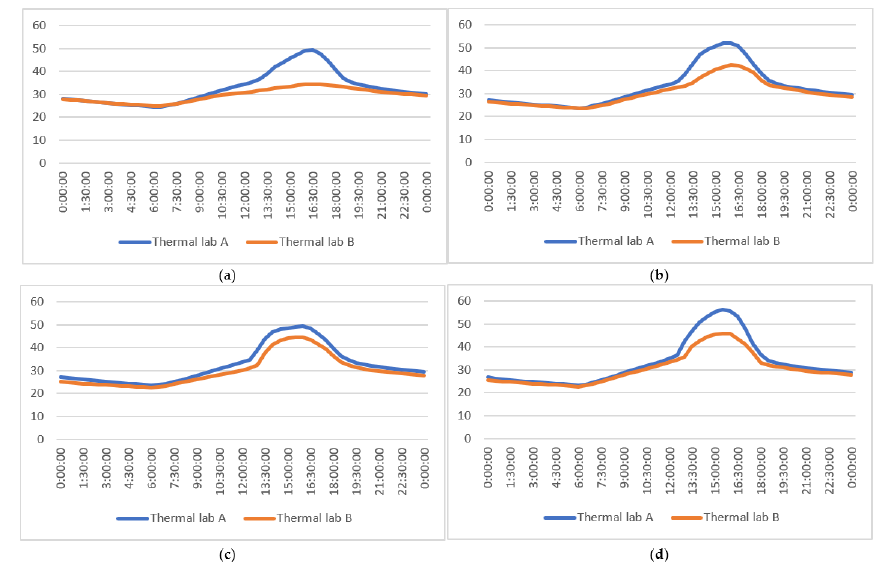
Figure 10. ( a ) P1 temperature; ( b ) P2 temperature; ( c ) P3 temperature; ( d ) P4 temperature. Table 9. Comparison of temperature measuring points in two rooms. Measuring Points